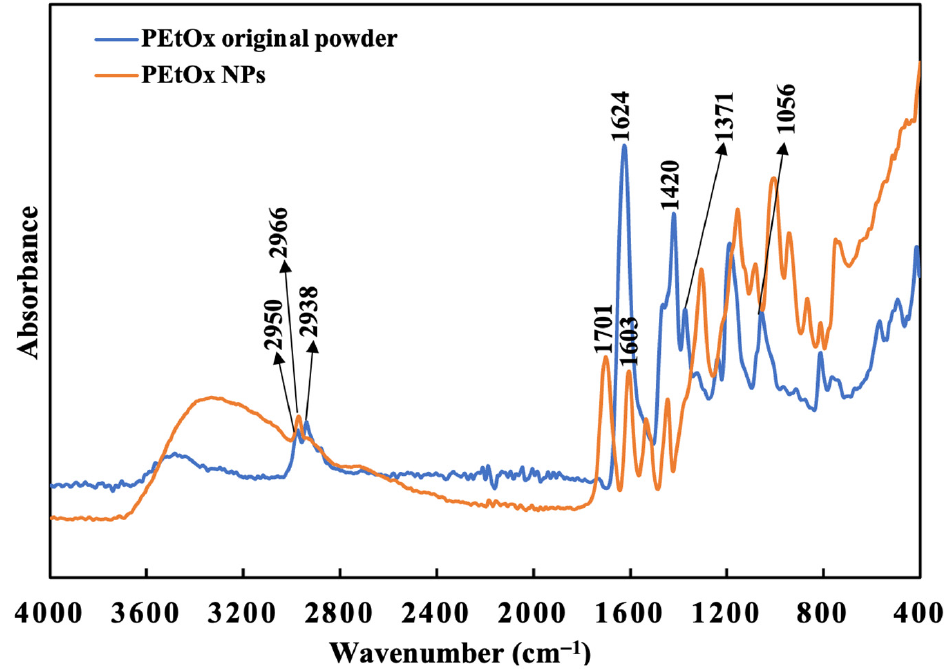
Figure 8. FTIR spectra of PEtOx powder and PEtOx NPs before incubating them in SLF.